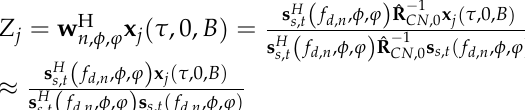
Figure 3. Diagrammatic sketch of sliding window processing. The inconsistent sub-CPI second-order CCM estimations in the calculation of STAP weight vectors will lead to the nonlinear phase response, which might cause the target Doppler history corruption of STAP outputs among sub-CPIs and the SCNR perfor- mance degradation of the following long-CPI coherent accumulation. To tackle this issue, we adopt a sample selection [30] and covariance smoothing [31] approaches with the whole secondary data, by which the linear phase response of STAP is guaranteed with the consistent CCM estimation among sub-CPIs; that is